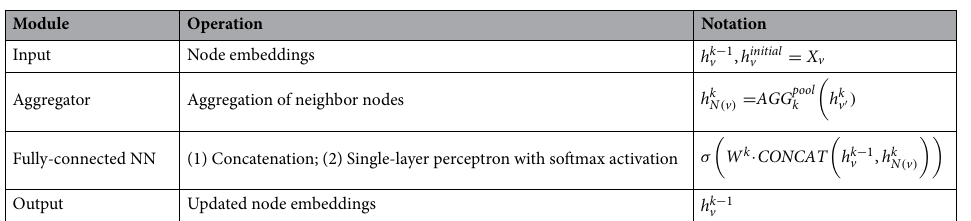
Module Operation